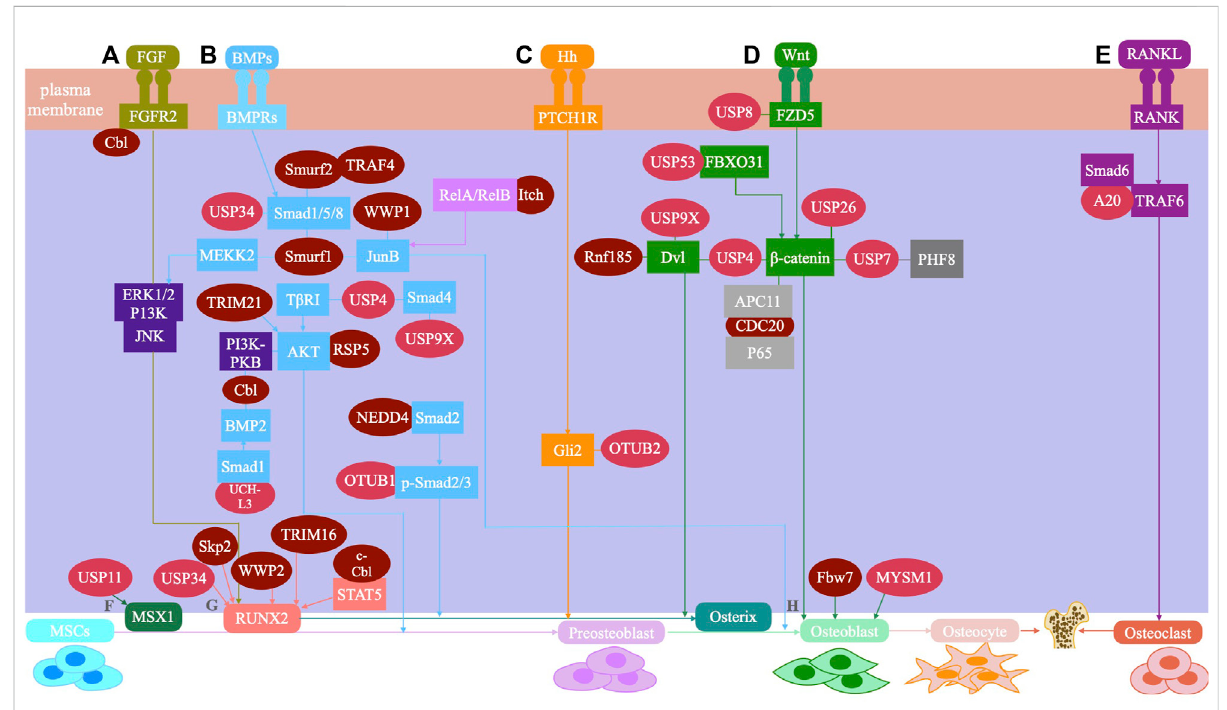
FIGURE 2 TheUPSsystemmediatedsignalingpathwayandregulatoryfactorsduringosteogenicdifferentiationofmesenchymalstemcellsareshown. (A) FGF signaling: Smur fl inhibits JNK signaling by promoting MEKK2 ubiquitination and degradation, and negatively regulates FGF signaling. Cbl can reduce the ubiquitination of PDGFR and FGFR2, thus inhibiting FGF signaling. (B) BMP signaling: USP4 can deubiquitinate TI3RI and Smad4, and enhance BMP signaling. USP9X can antagonize Smad4 monoubiquitination and enhance BMP signaling. USP34 can activate Smad1/5/8 to enhance BMP signaling. UCH-L3 can deubiquitinate and stabilize Smadl, and enhance BMP signaling. OTUB1 deubiquitinates the p-Smad2/ 3 complex and enhances BMP signaling. Smur fl and Smurf2 induce Smad1/5/8 ubiquitination and negatively regulates BMP signaling. Smur fl and WWP1 promote ubiquitination and degradation of JunB and inhibit BMP signaling. Itch enhances JunB by ubiquitinating ReIA/Re1B and positively regulatesBMPsignaling.RSP5inducesubiquitinationofPKB/AktandpositivelyregulatesBMPsignaling.TRIM21acceleratedthedegradationofAktto enhance BMP signaling. Cbl reduces BMP signaling by inhibiting PI3K-PKB/Akt pathway and ubiquiting BMP2. TRAF4 positively regulates BMP signaling by ubiquitinating Smurf2. (C) Hedgehog signaling: OTUB2 enhances Hh signaling through deubiquitinating Gli2. (D) Wnt signaling: USP4 enhances Wnt signaling through deubiquitinating and stabilizing P-catenin. Conversely, USP4 inhibits Wnt signaling by deubiquitinating Dvl. USP9X enhances Wnt signaling through deubiquitinating Dv12. USP8 enhances Wnt signaling through deubiquitinating FZD5. USP53